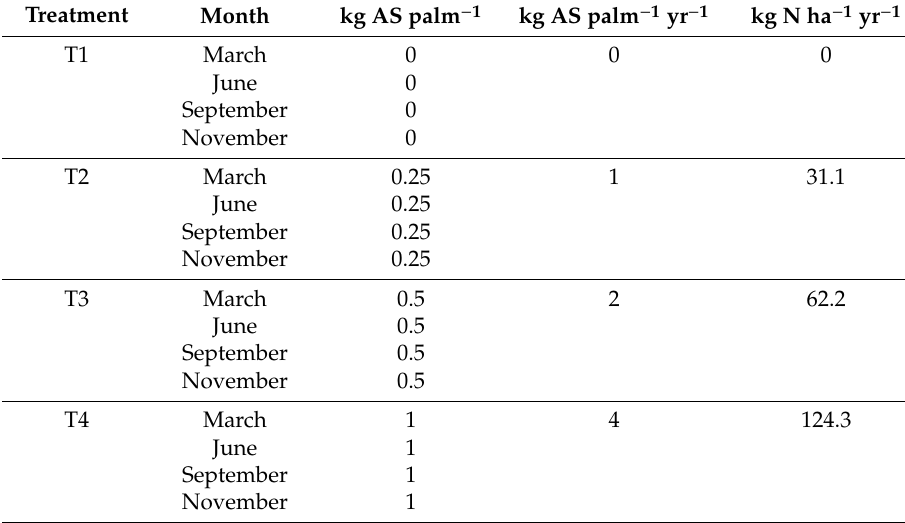
Table 1. Rate of ammonium sulphate (AS).